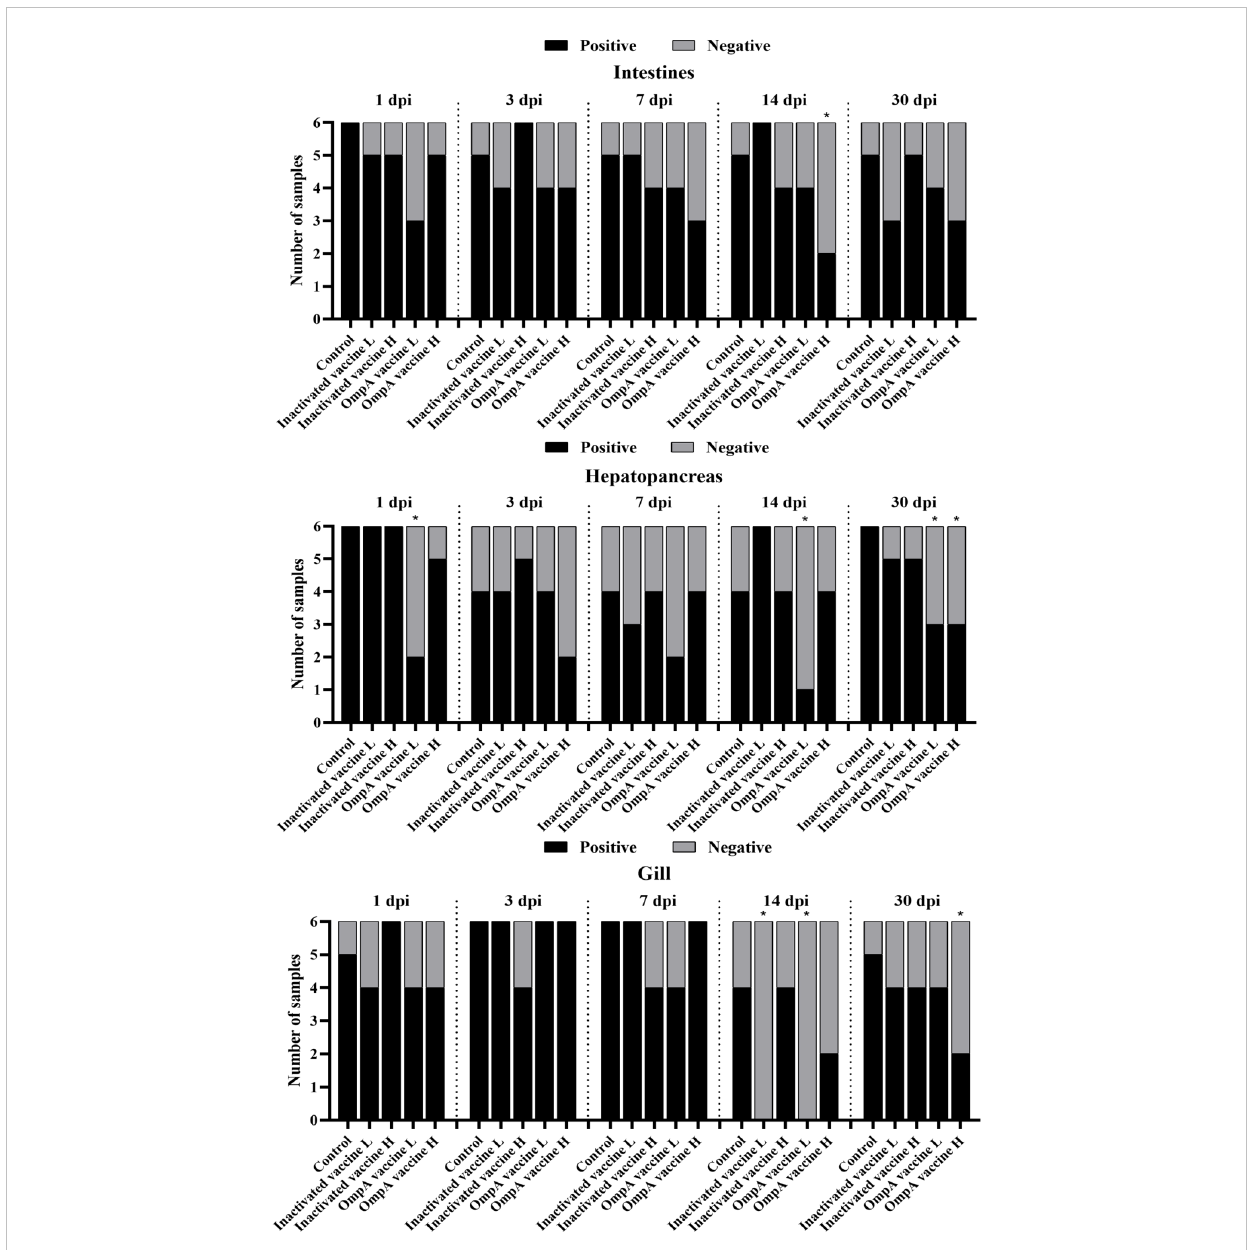
FIGURE 4 Infection of M. amblycephala in experimental groups expressed as percentage of fi sh carrying A. hydrophila in different organs following challenge quanti fi ed by RT-qPCR with 16S rRNA . *: Signi fi cant difference compared to the control group at each time point ( P <